Question: From the figure, is the trend upward or downward?
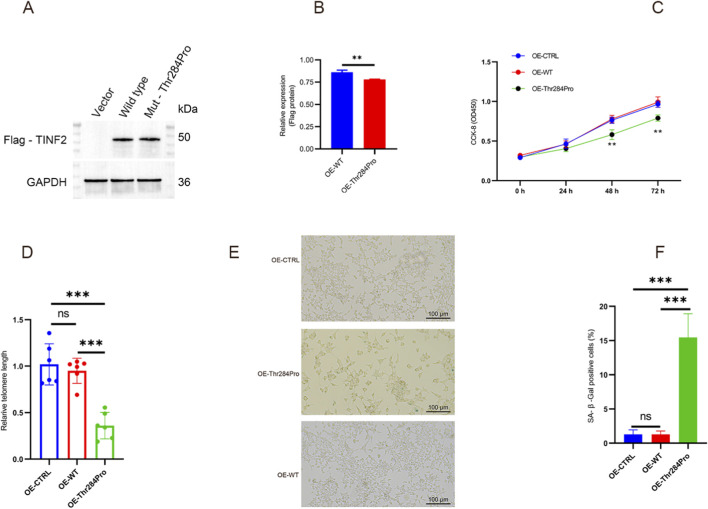
Answer: increasing